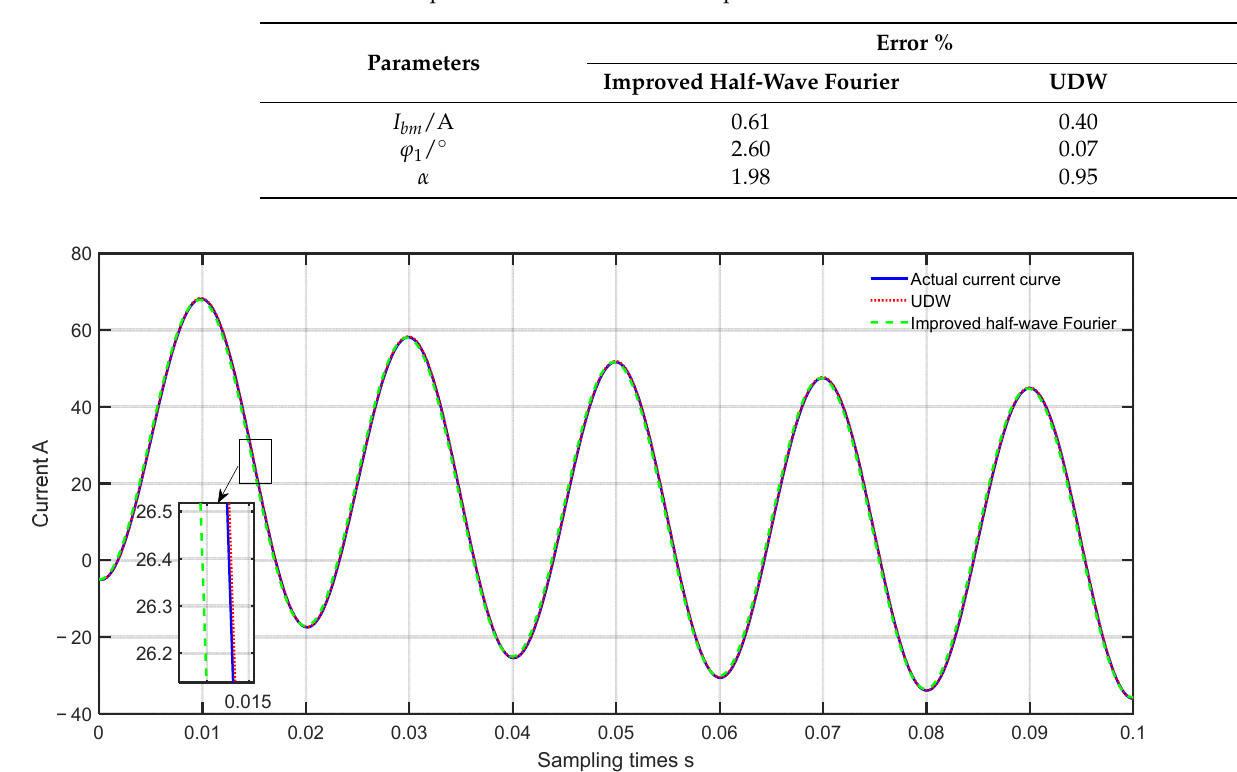
Figure 5. Comparison of two waveform parameter prediction methods for fitting